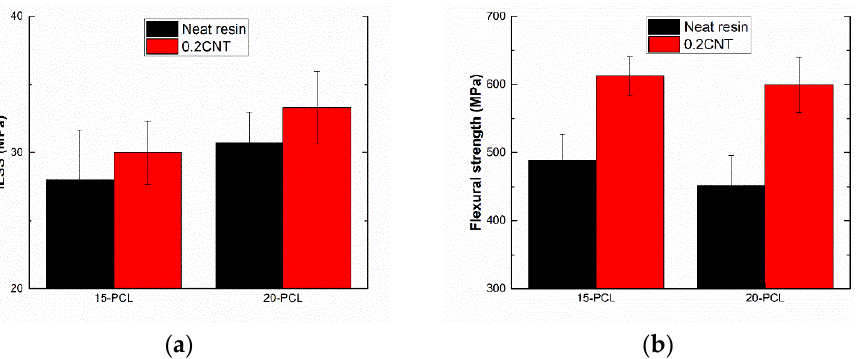
Figure 2. ( a ) ILSS and ( b ) flexural strength of GFRP samples at the different tested